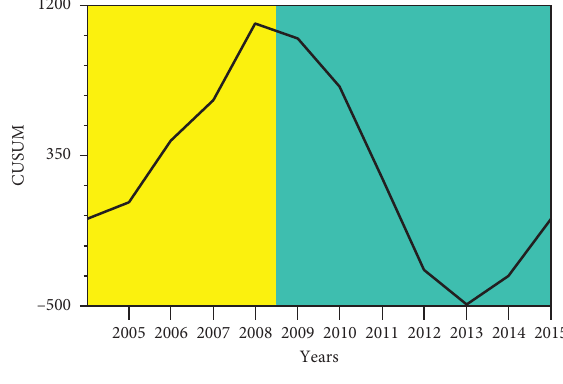
Figure 5: Gauteng: CUSUM plot.